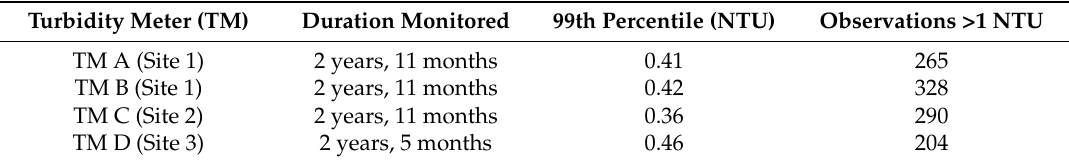
Table 2. Summary of turbidity observations for each site.